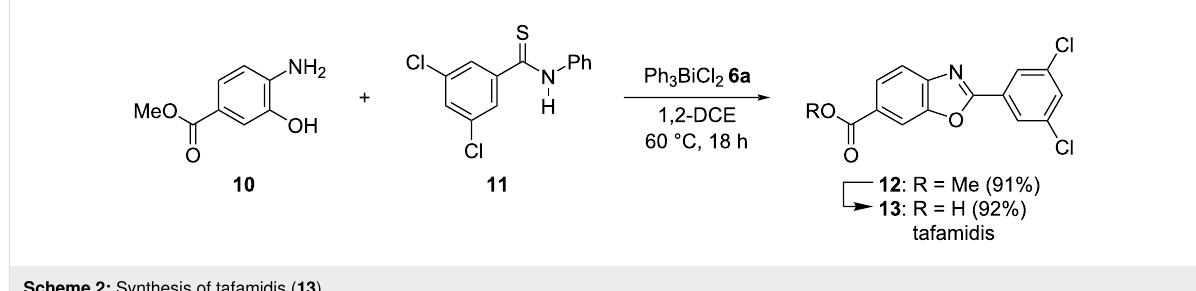
Scheme 2: Synthesis of tafamidis ( 13